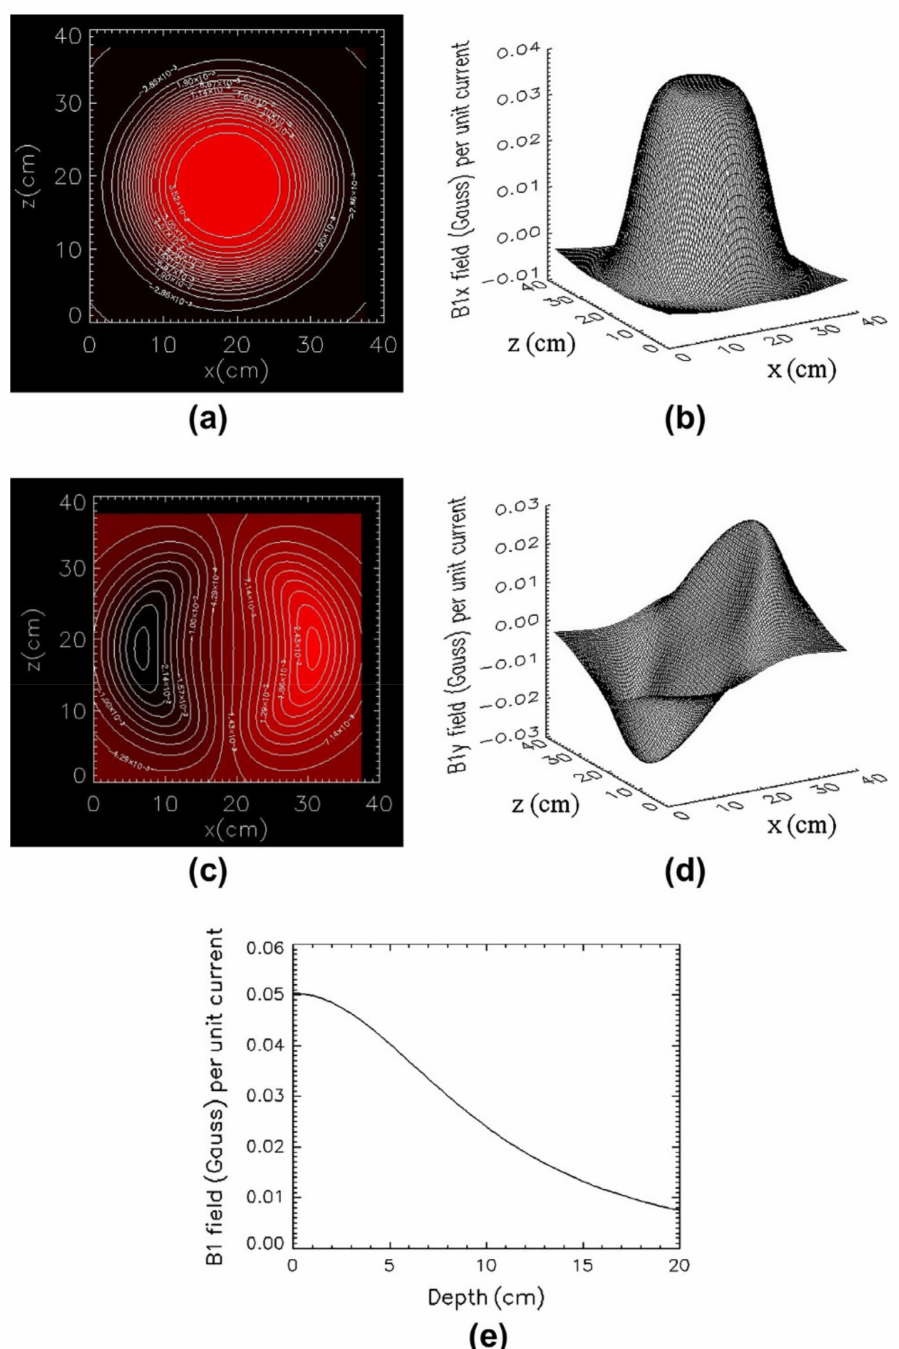
Figure 6. ( a ) Coil magnetic field pattern: Bx component as contour plot; ( b ) 3D plot; ( c ) by component as contour plot; ( d ) 3D plot; ( e ) normalized magnetic field along coil axis. Reprinted by permission from Giovannetti et al., Measurement 2014